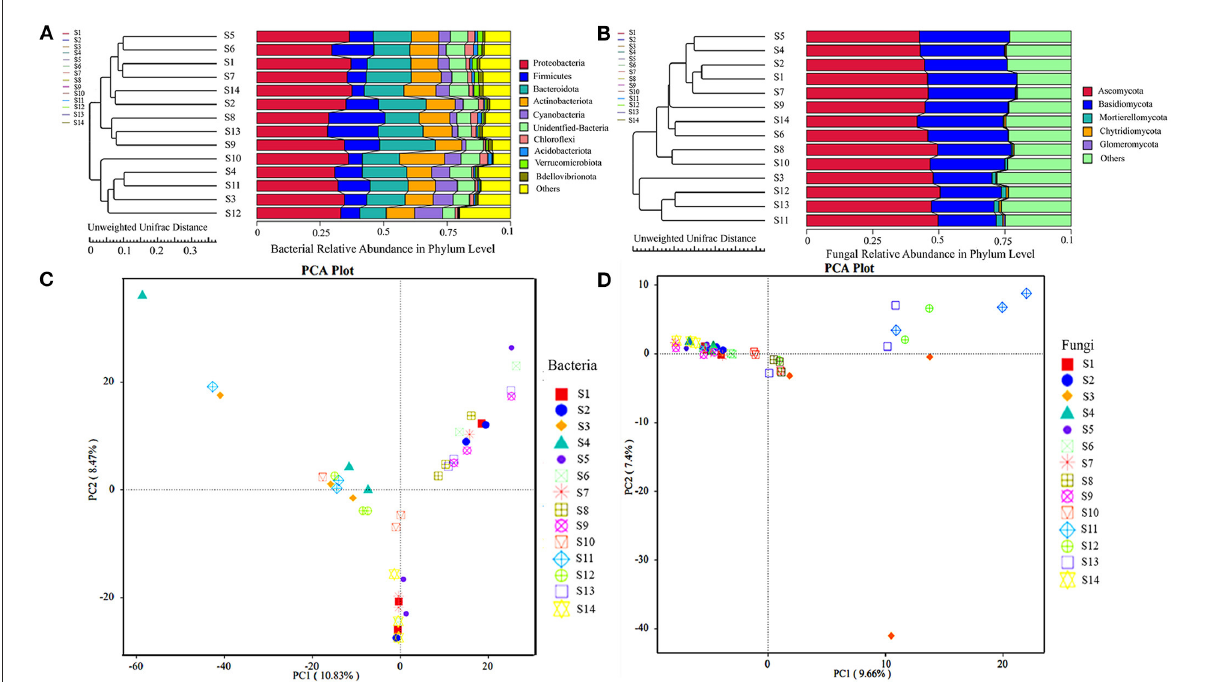
FIGURE4 Analysis of F. sinensis seeds microbial communities with unweighted UniFrac. Principal component analysis (PCA) of bacterial (A) and fungal community (B) with unweighted UniFrac. Symbols represent different F. sinensis seeds. UPGMA tree based on unweighted UniFrac distance at the phylum level. Explanation: On the left is the UPGMA cluster tree structure, and on the right is the species relative abundance distribution at the phylum level for each sample. The phylogenetic relationship of the bacteria and fungi was determined by PCR sequencing portions of the 16S rRNA gene (C) and ITS gene (D) .